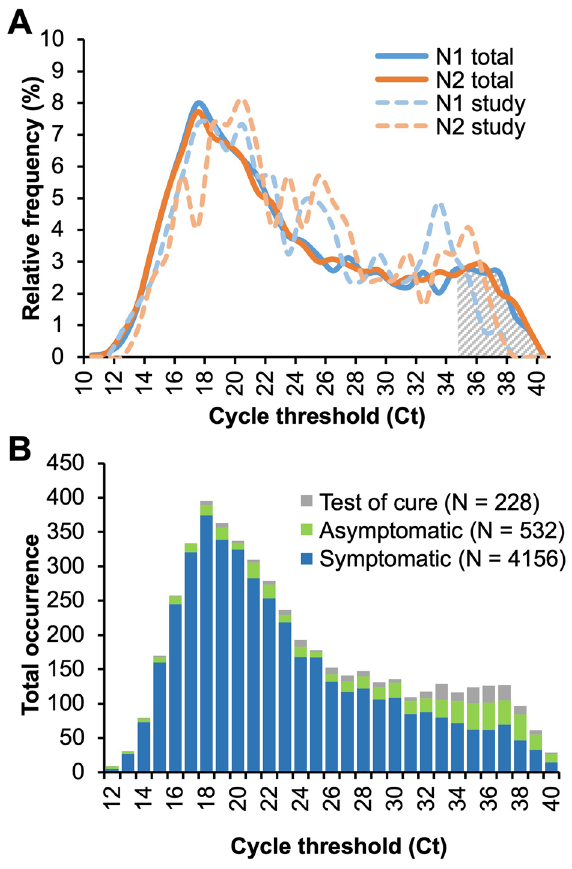
Figure 7. Comparisons of the C t distributions for positive specimens performed in VUMC from Mar 2020– Mar 2021 using the CDC qRT-PCR. A) Ct distribution for N1 (solid blue line) and N2 (solid orange line) of total positives versus the N1 (dotted blue line) and N2 (dotted orange line) for the 41 samples used in this study. B) Distribution of the Ct values for all positive tests from three patient groups: symptomatic (blue), asymptomatic (green), and test of cure